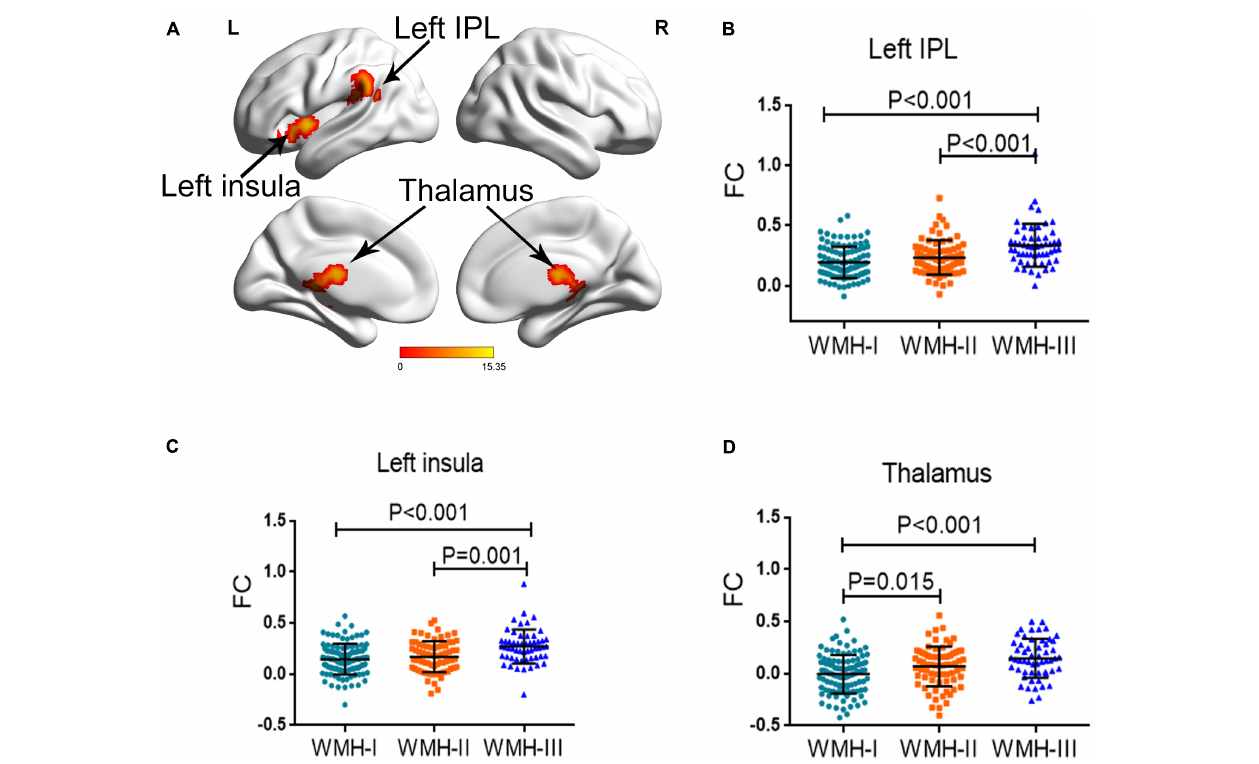
FIGURE 2 | Group differences of FC across the three groups. (A) The regions displayed a significant difference among the three groups (left insula, left IPL, and thalamus). FC, functional connectivity; IPL, inferior parietal lobule. (B) The subjects in WMH-III displayed a significantly greater FC in the left IPL than the subjects in the other two groups. (C) The subjects in the WMH-III group displayed a significantly higher FC in the left insula than the subjects in the other two groups. (D) The subjects in the WMH-III and WMH-II groups displayed a significantly greater FC in the thalamus than the subjects in the WMH-I group. FC, functional connectivity; IPL, inferior parietal lobule; WMH, white matter hyperintensity.